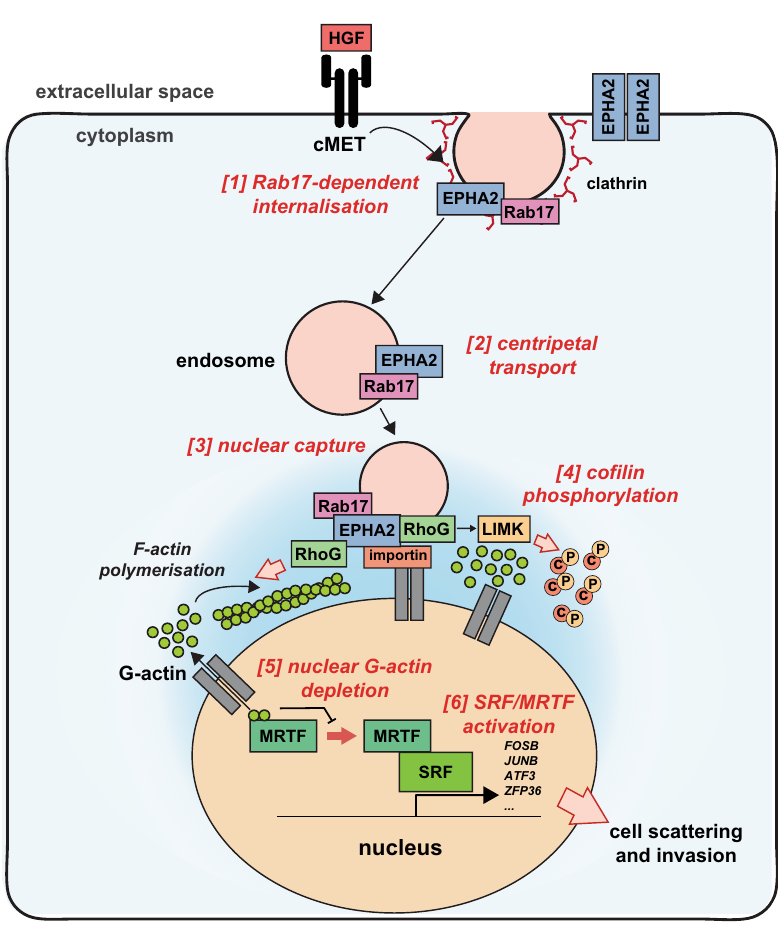
Fig. 8 Schematic summary of the role played by nuclear-capture of EphA2 endosomes in controlling nuclear G-actin dynamics. MET drives clathrin and Rab17-dependent endocytosis of EphA2 [1]. EphA2/Rab17-positive endosomes are then transported centripetally [2] and become physically attached to, or ‘ captured ’ by, the nucleus by an interaction formed between the nuclear import machinery and a nuclear localization sequence located in EphA2 ’ s cytodomain [3]. This nuclear-capture event, in turn, drives actin polymerization, which is restricted to the juxta-nuclear region [4] and LIMK-driven phosphorylation of co fi lin [5], and both events are dependent on the RhoG GTPase. Phosphorylation of co fi lin opposes nuclear import of co fi lin – actin, leading to depletion of G-actin from the nucleus [6], which, in turn, activates transcription of MRTF/SRF target genes [7] to implement cell scattering and